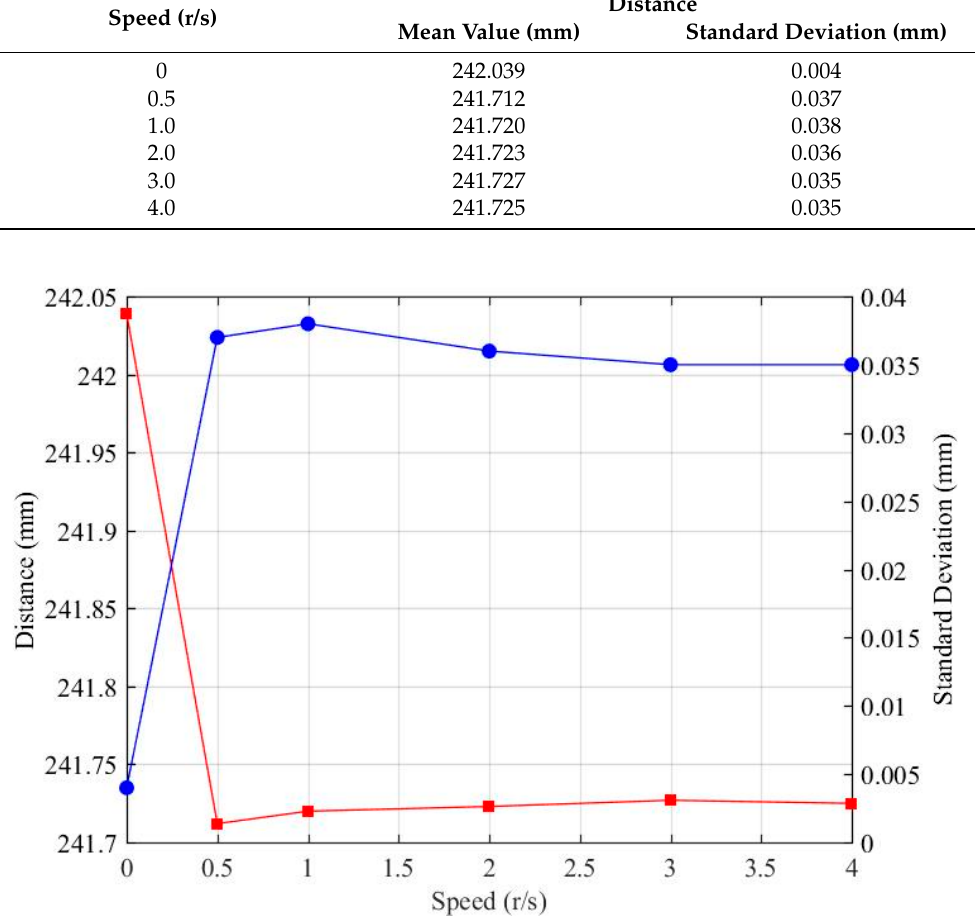
Figure 17. The relationship between the distance between two points and the rotational speed. The moving speed of a target point can be calculated according to the spatial coordi- nates of the measured target point at a certain time and the time of image collection. About 400 frames of images are collected at each speed. The calculated results at different speeds are as follows (shown in Table